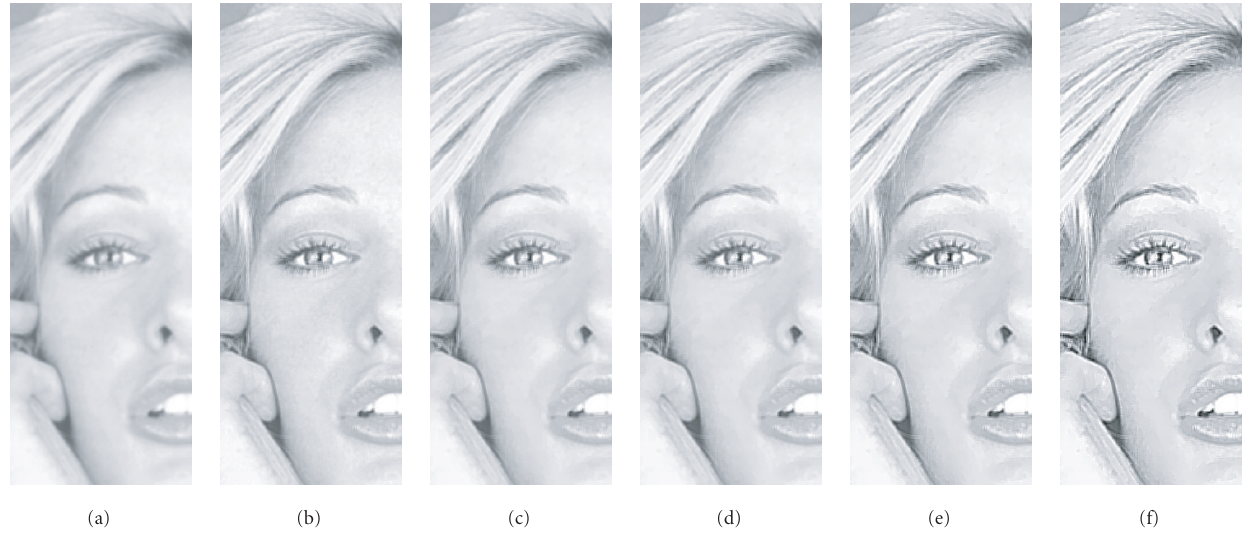
Figure 7: (a) Detail of blurred image, and results given by di ff erent parameter settings: (b) k sh = 5 and k sm = 0, (c) k sh = 5 and k sm = 1, (d) k sh = 6 and k sm = 1, (e) k sh = 10 and k sm = 1, and (f) k sh = 15 and k sm =